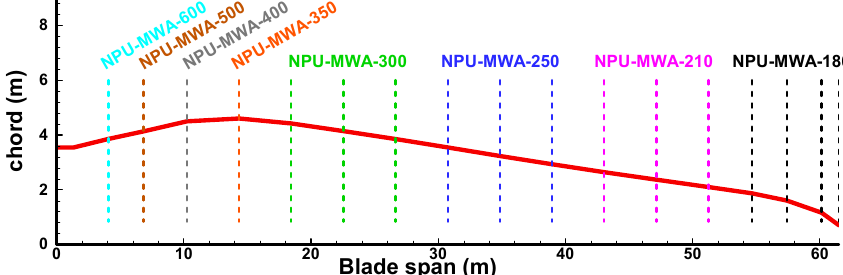
Figure 17. Span-wise airfoil arrangement of the designed NPU 5 MW wind turbine blade.